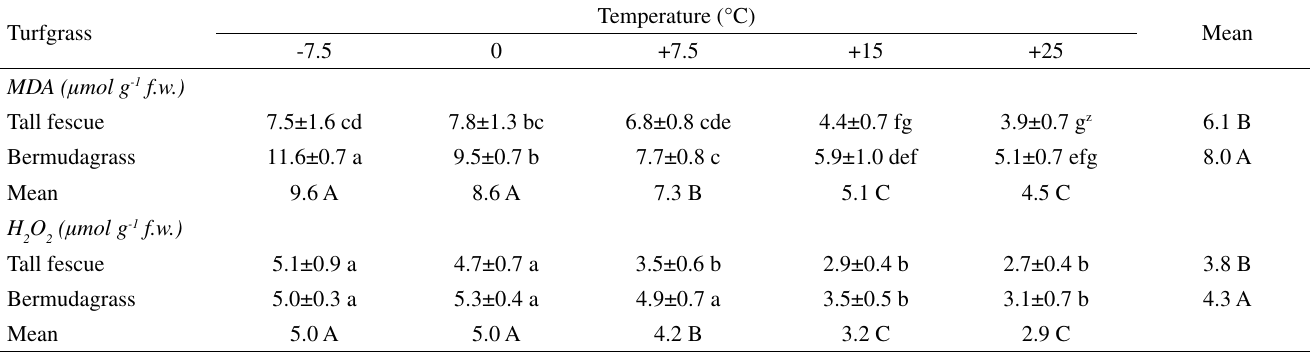
O ) in the two turfgrasses used in this study 2 2